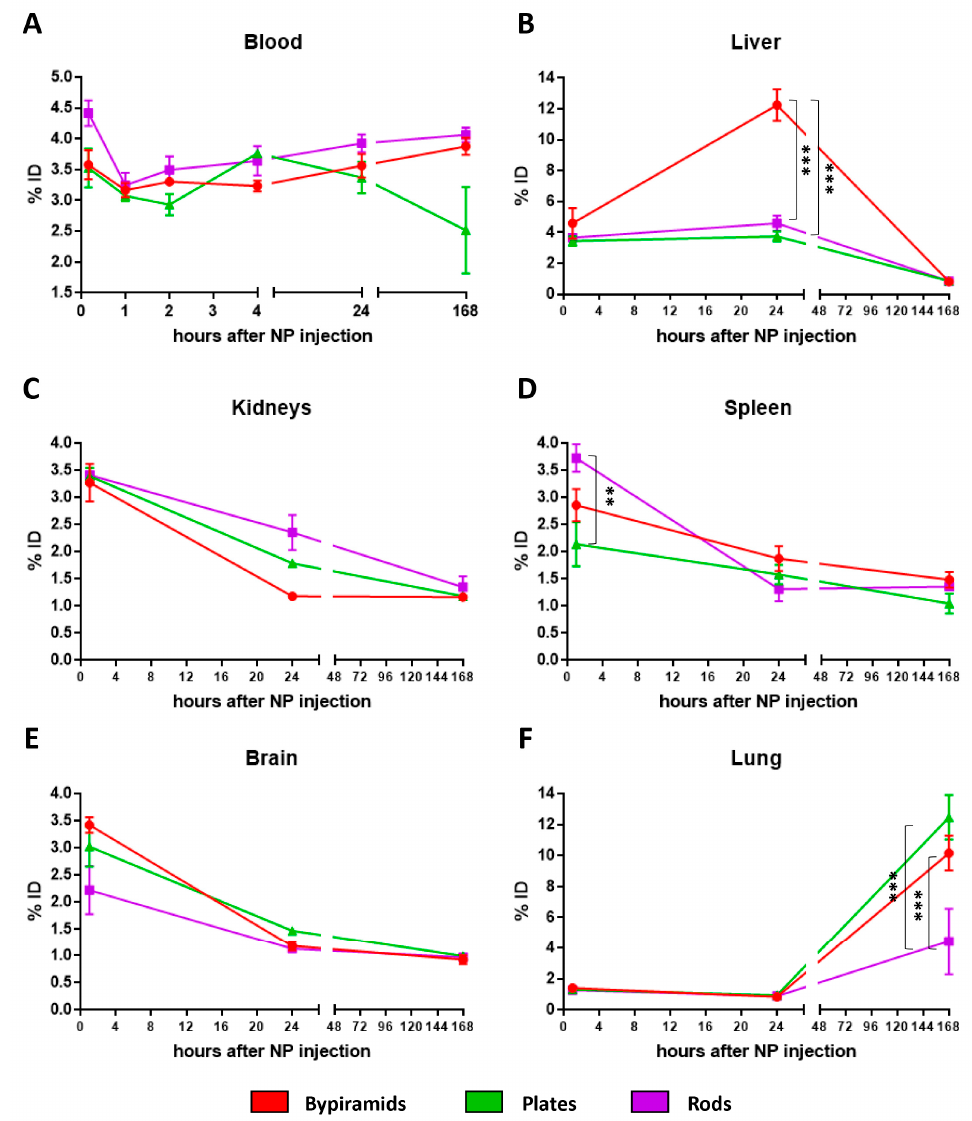
Figure 4. Ti organ content. Percentage of injected dose (%ID) measured by ICP-MS in blood derived from mice treated with di ff erent TiO 2 NPs at 10 ′ , 1, 2, 4, 24, and 168 h after treatment ( A ) and in the following collected organs (( B – F ): liver, kidneys spleen, brain, and lung) derived from mice treated with different TiO 2 NPs at 1, 24, and 168 h after treatment. The data are reported as mean ± SEM. A one-way ANOVA followed by a Bonferroni post hoc test was carried out. Significant difference (** p < 0.01, *** p < 0.001) when comparing the different shapes at the same time point is